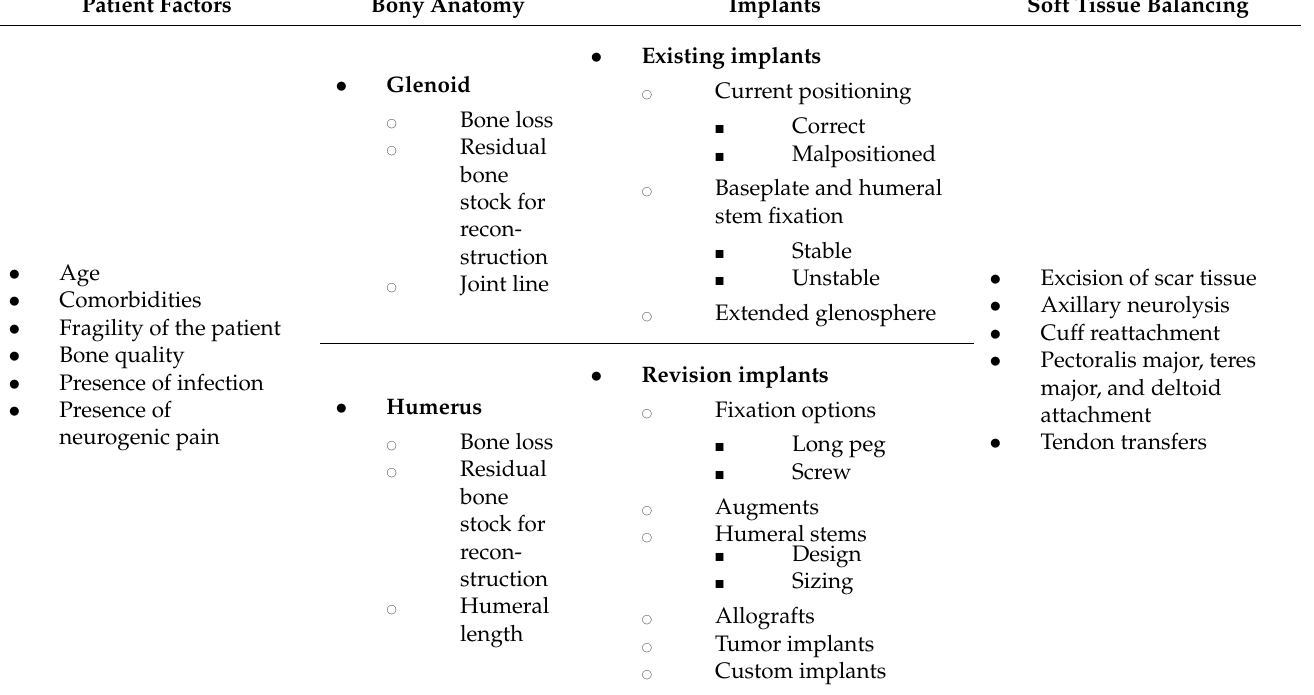
Table 1. Factors to take into consideration for the management of revision shoulder